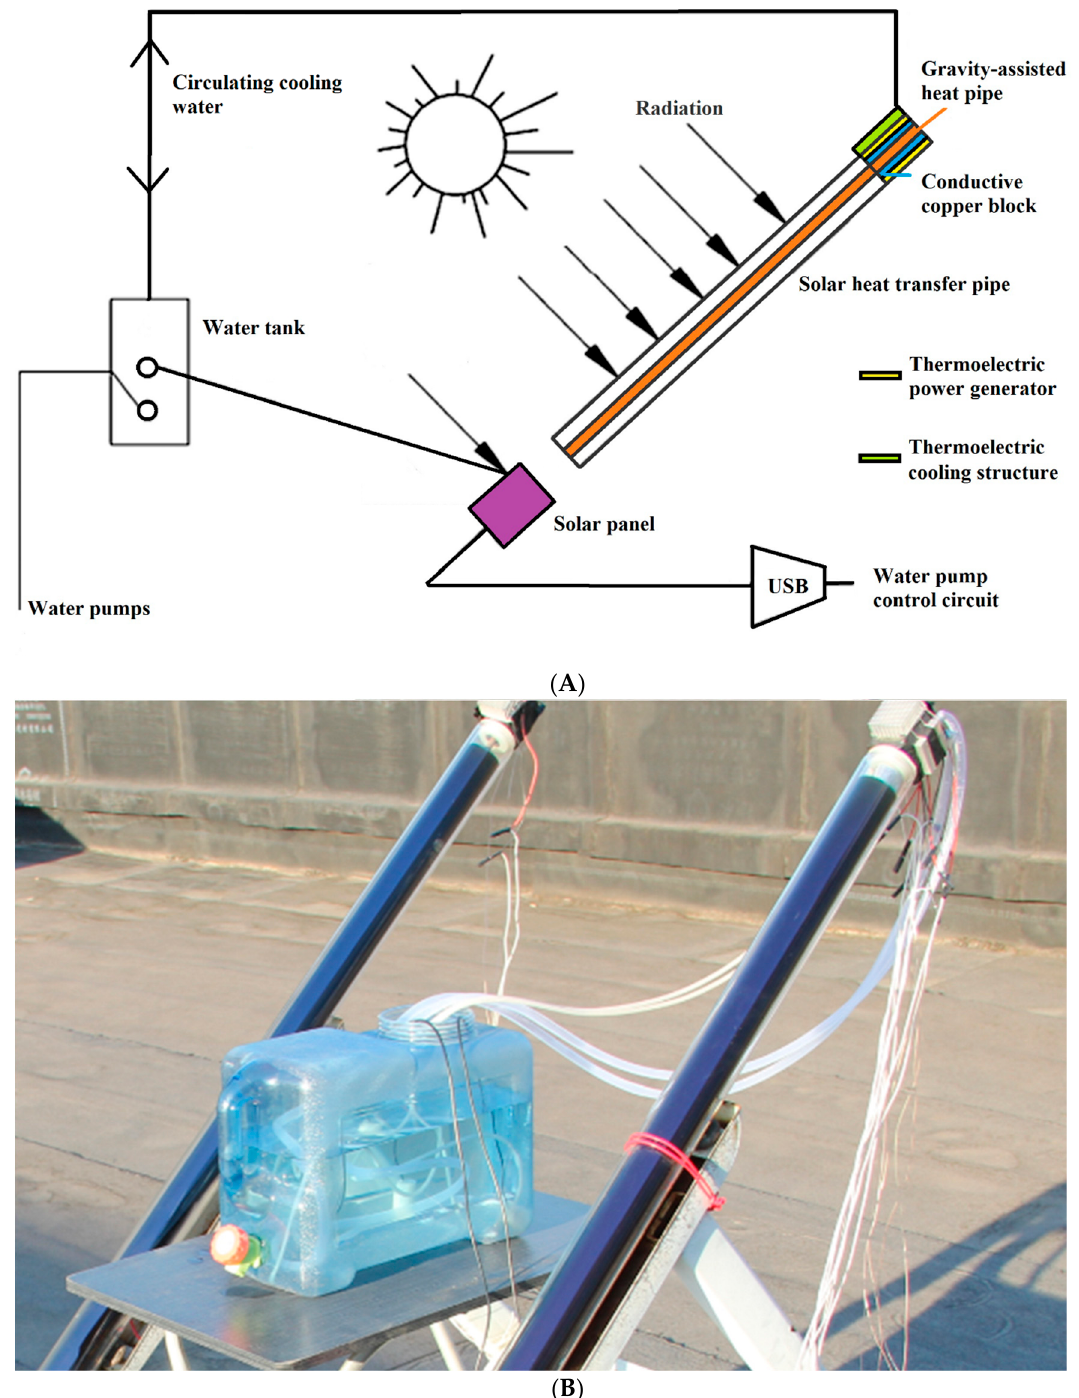
Figure 1. Solar thermoelectric power ‐ generation device: ( A ) schematic diagram; ( B ) experimental rig.